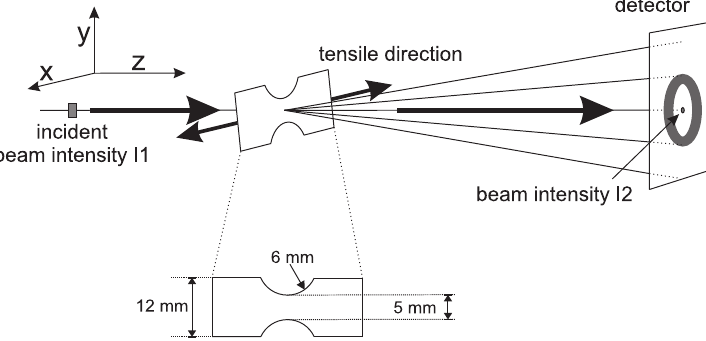
Figure 3. Schematic representation of the tensile setup, combined with in situ X-ray